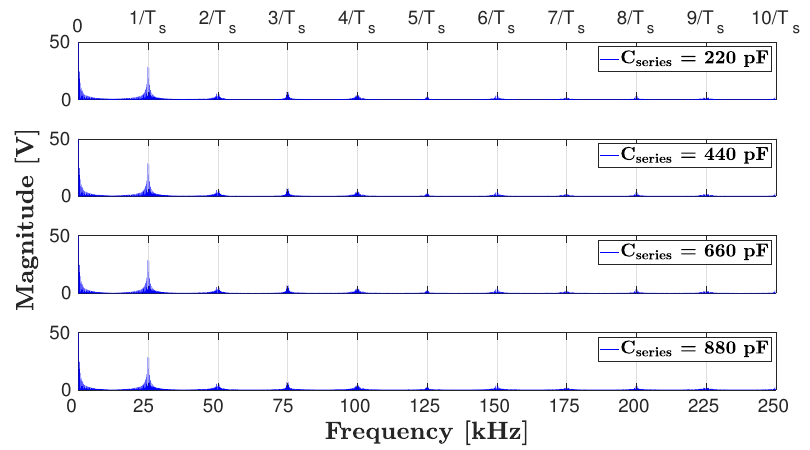
Figure 15. FFT of v cmZC with different values of C series .